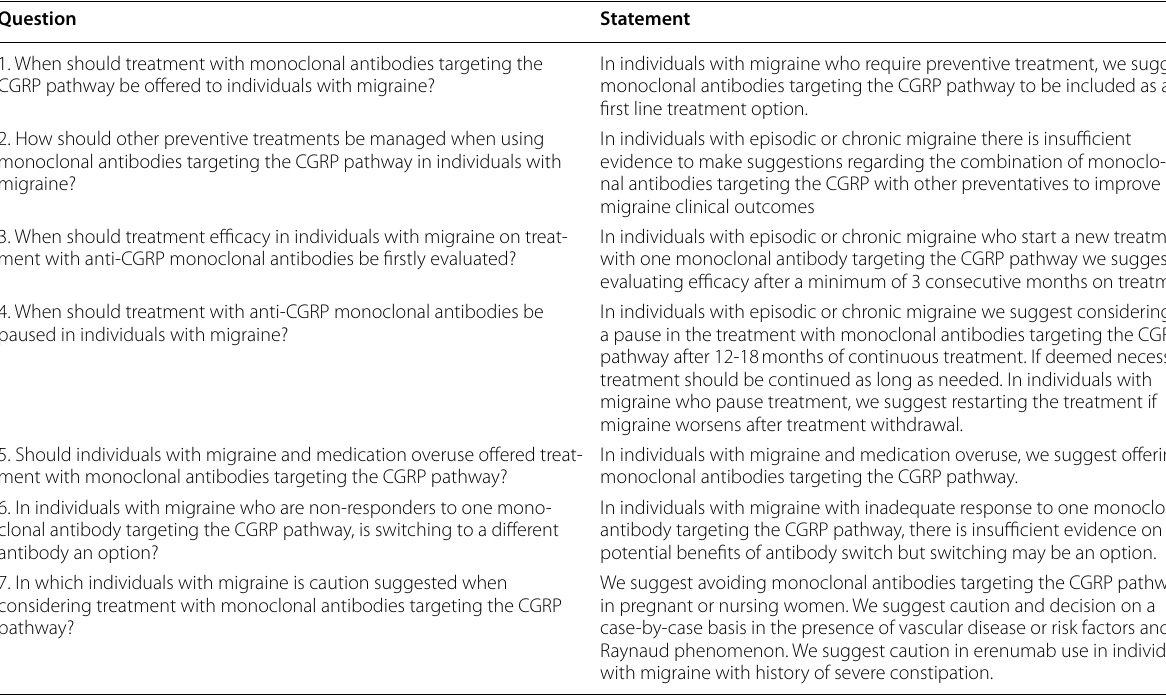
Table 9 Summary of the expert consensus